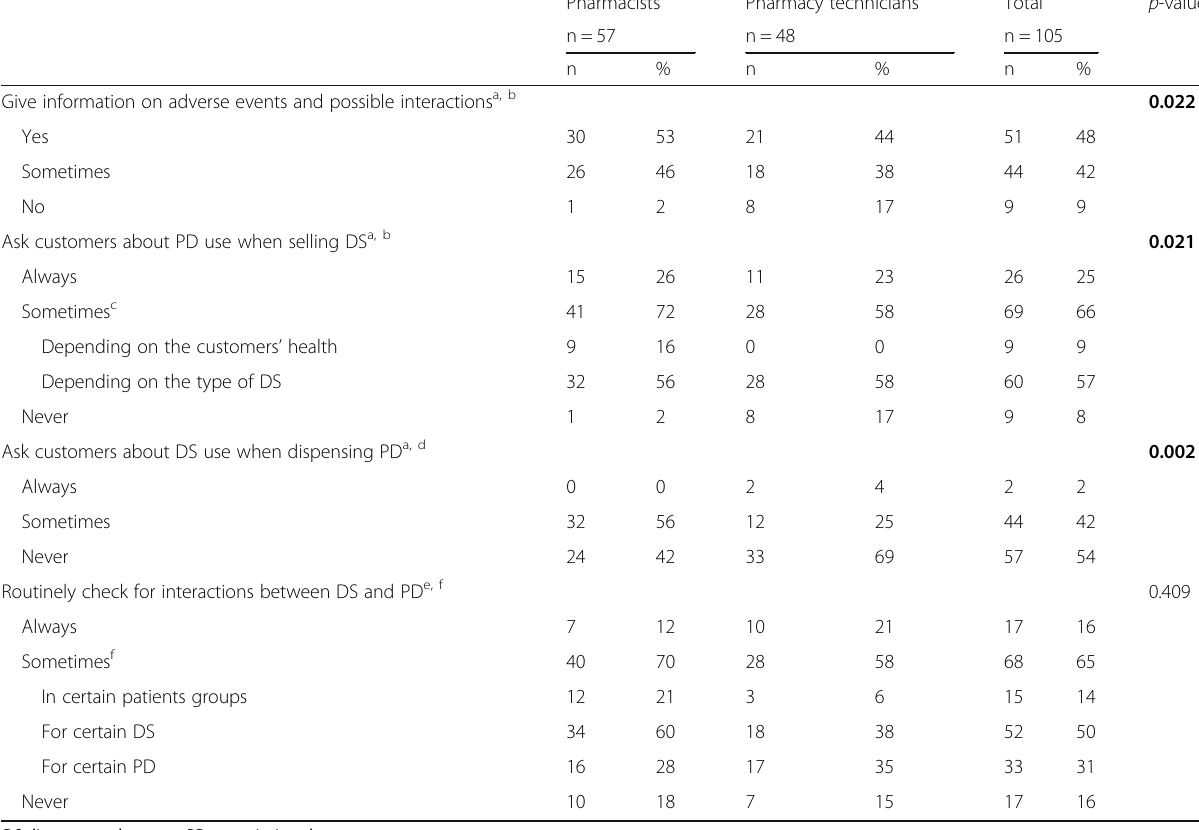
Table 2 Pharmacy employees ’ professional practice behaviors related to dietary